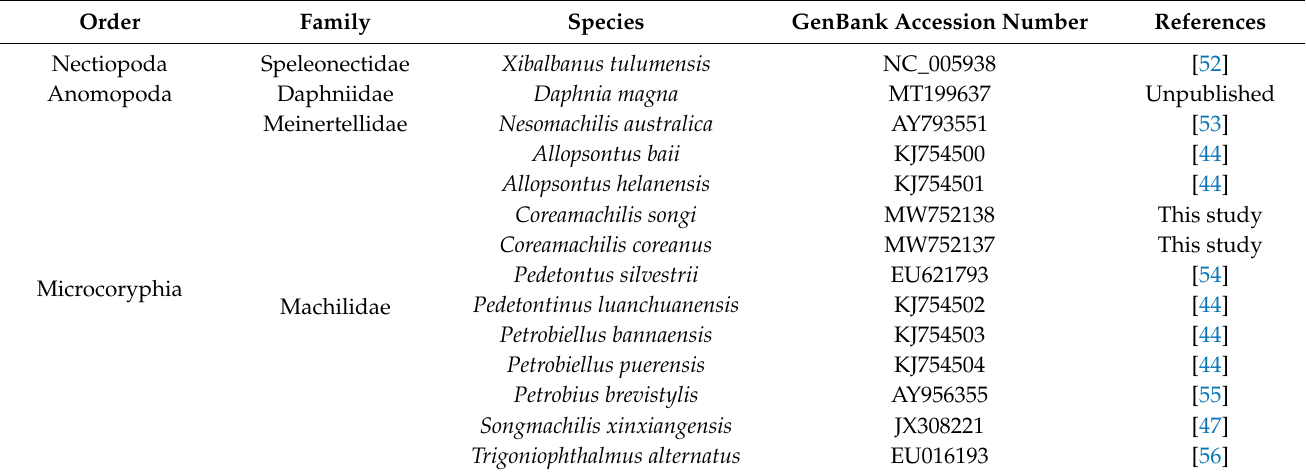
Table 2. Species used to construct the phylogenetic relationships along with GenBank accession numbers. Order